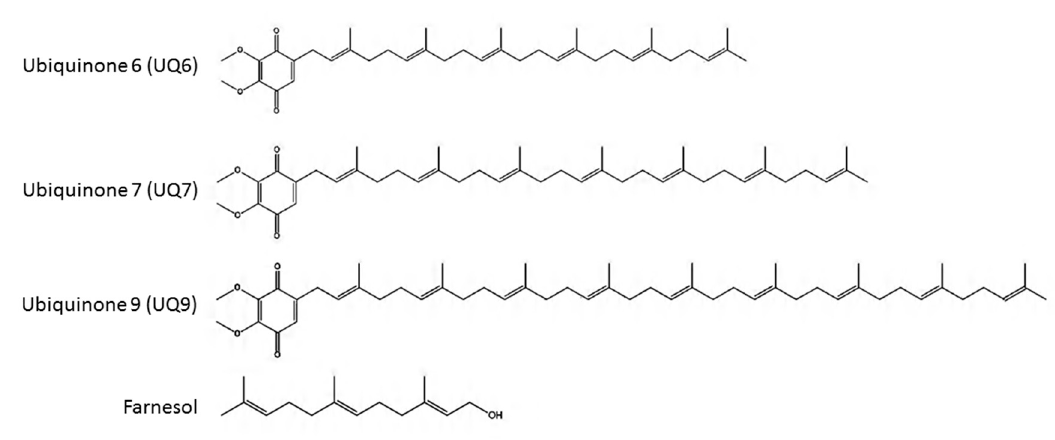
Figure 1. Structures of ubiquinones and farnesol. Ubiquinone consists of a benzoquinone ring (aromatic moiety) and a side chain of variable isoprenoid units. S. cerevisiae has six isoprenoid units in its side chain (UQ6), while most Candida sp. have seven (UQ7), and C. albicans has nine (UQ9). Farnesol, is a C 15 sesquiterpene alcohol with only three isoprenoid units.